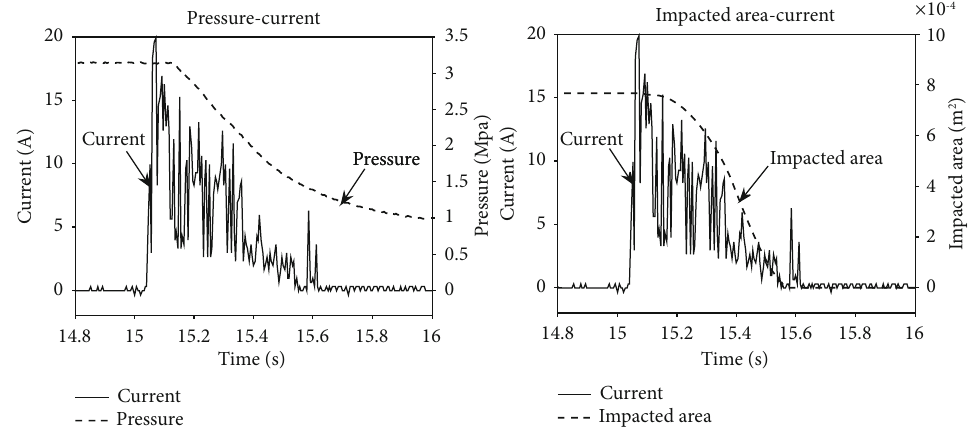
Figure 4: Motor current decrease with the decrease of the pressure and the impact